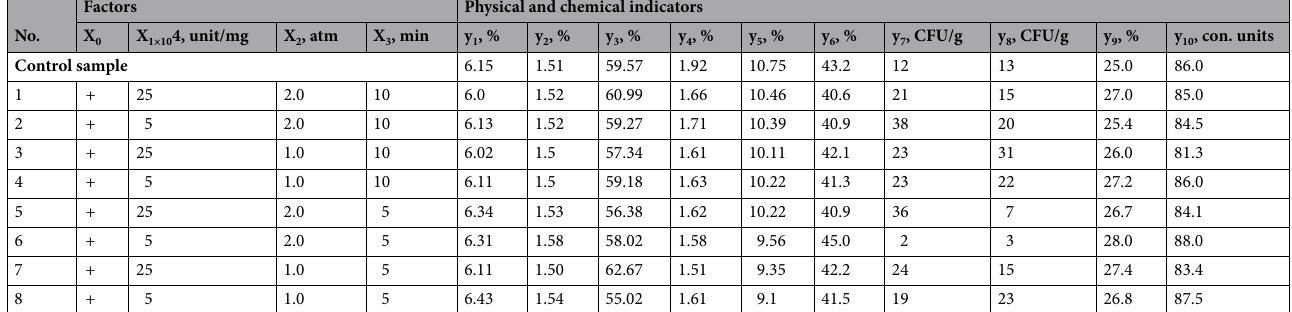
Table 2. Physical and chemical parameters of flour obtained from whole-ground class 3 wheat with ion-ozone cavitation treatment. y 1 —protein, y 2 —mass fraction of fat, y 3 —carbohydrates, y 4 —ash content, y 5 —mass fraction of fibre, y 6 —whiteness of flour, y 7 —amount of yeast, y 8 —amount of mould, y 9 —amount of gluten, y 10 —deformation of gluten (on the IDK